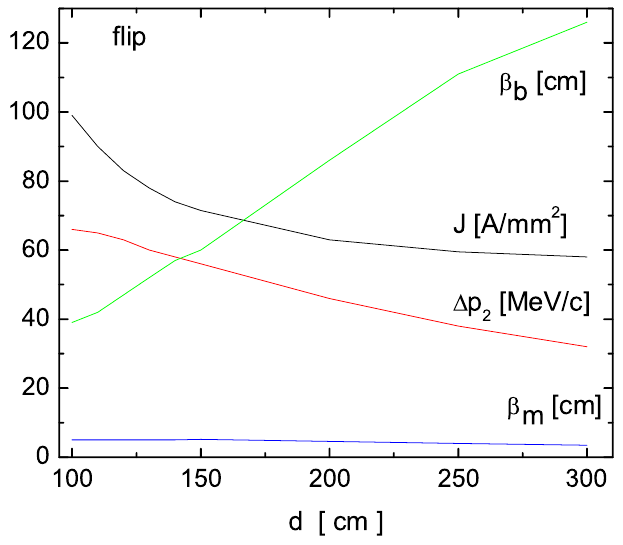
FIG. 9. (Color) Lattice parameters as a function of the cell length for the flip case. The beta function at the cell boundary and midplane, momentum acceptance, and current density to fixed at 200 MeV =c are shown. The other parameter keep p 2 values were L (cid:2) 40 cm , a (cid:2) 35 cm , and t (cid:2) 24 cm .